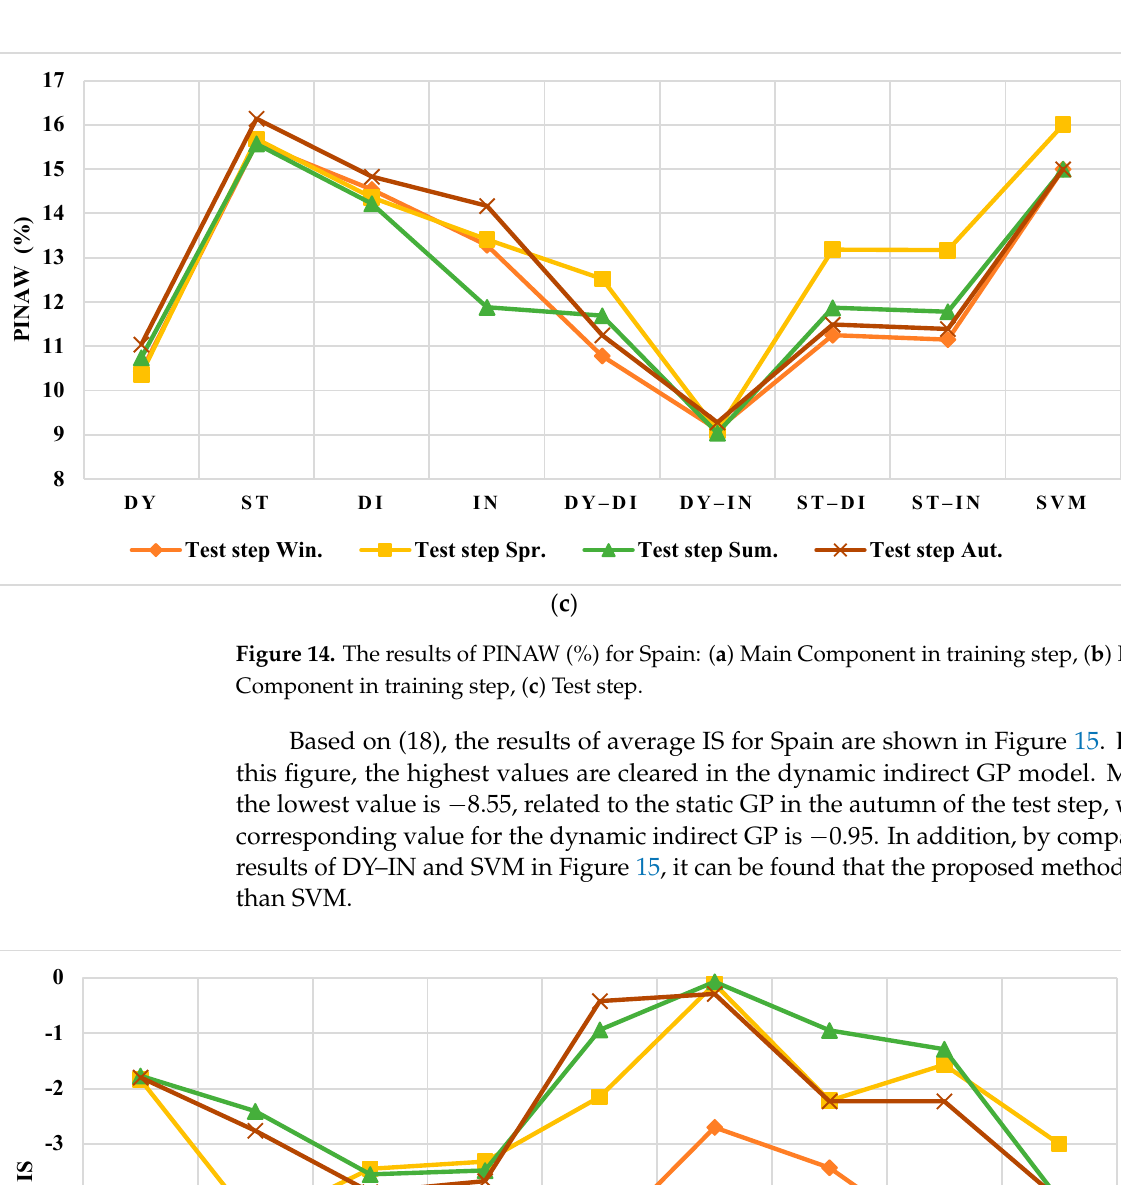
Main component in training step Spr. Main component in training step Sum. Main component in training step Aut.